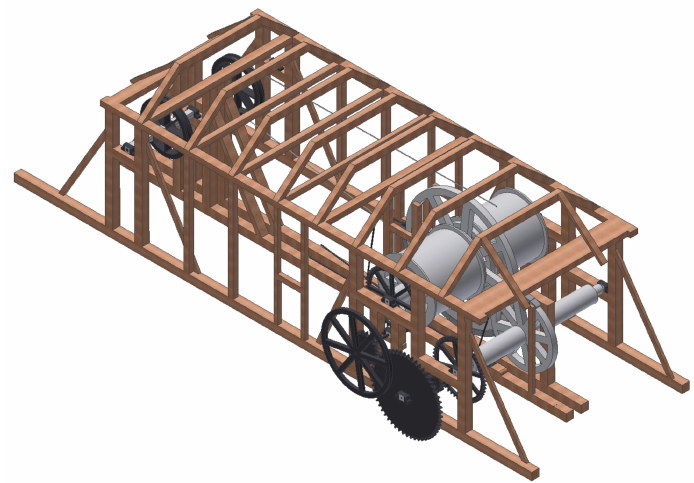
Figure 5. Simplified model of the Hay inclined plane for static